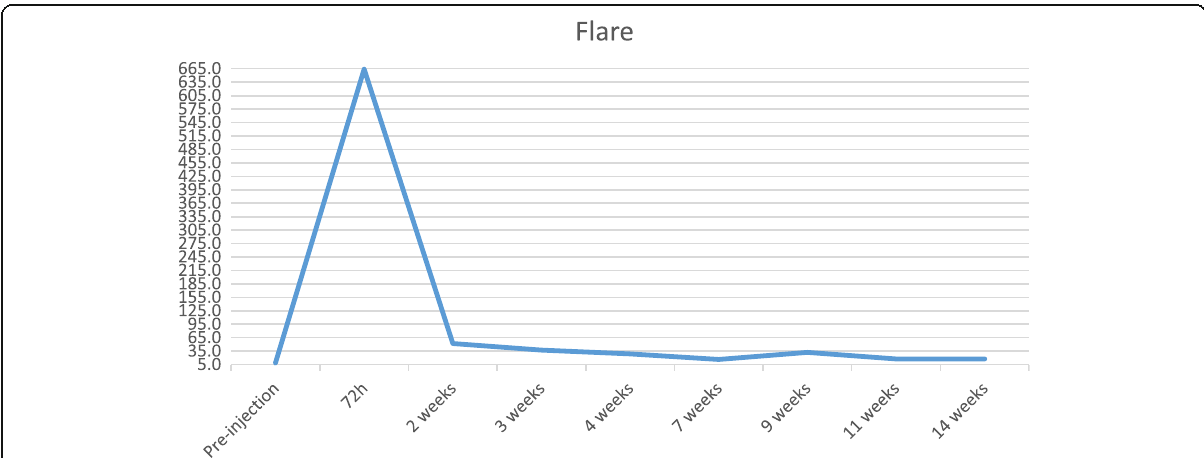
Fig. 3 Patient 1. Laser flare photometry values evolution from pre-injection level until last follow-up